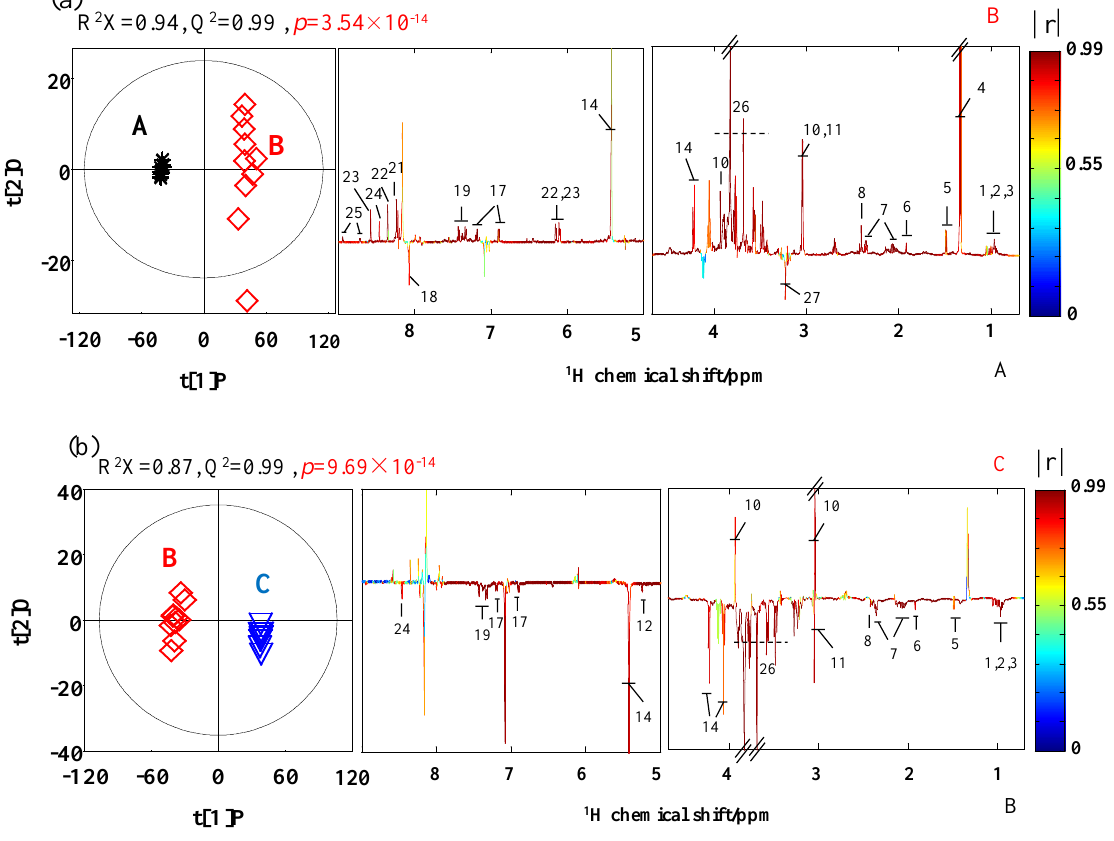
Figure 3. ( a ) OPLS-DA scores plots (left) and corresponding color-coded correlation coe ffi cient loadings Figure 3. OPLS-DA scores plots (left) and corresponding color-coded correlation coefficient plots (right) from SPHSS (A) and SPH (B). ( b ) OPLS-DA scores plots (left) and corresponding color-coded loadings plots (right) originated from comparisons between spectra of SPHSS ( A ), SPH ( B ) correlation coe ffi cient loadings plots (right) from SPH (B) and MRPH (C). The metabolite identification and MRPH ( C ), respectively. Metabolite identification keys to the numbers are shown in keys to the numbers are corresponded to Figure 1 and Table Figure 1 and Table 1.